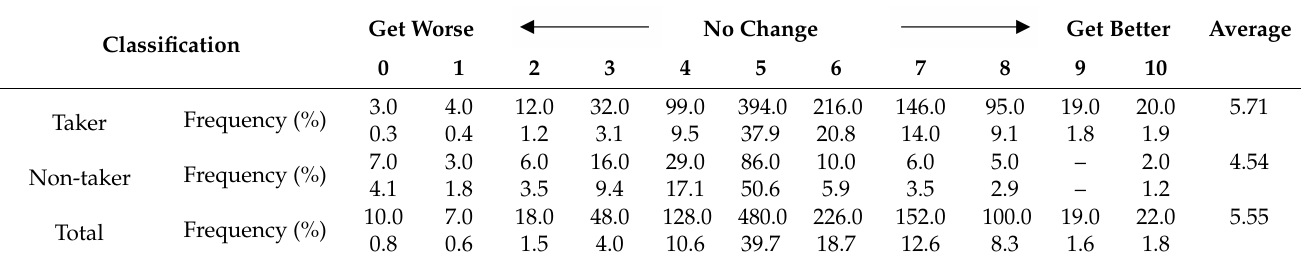
Table 1. A year comparison of health